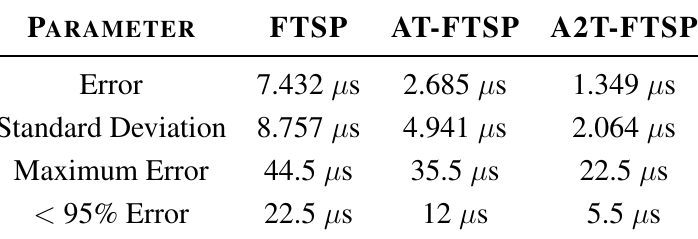
Table 5. Results with temperature variation: 22 ◦ C– 40 ◦